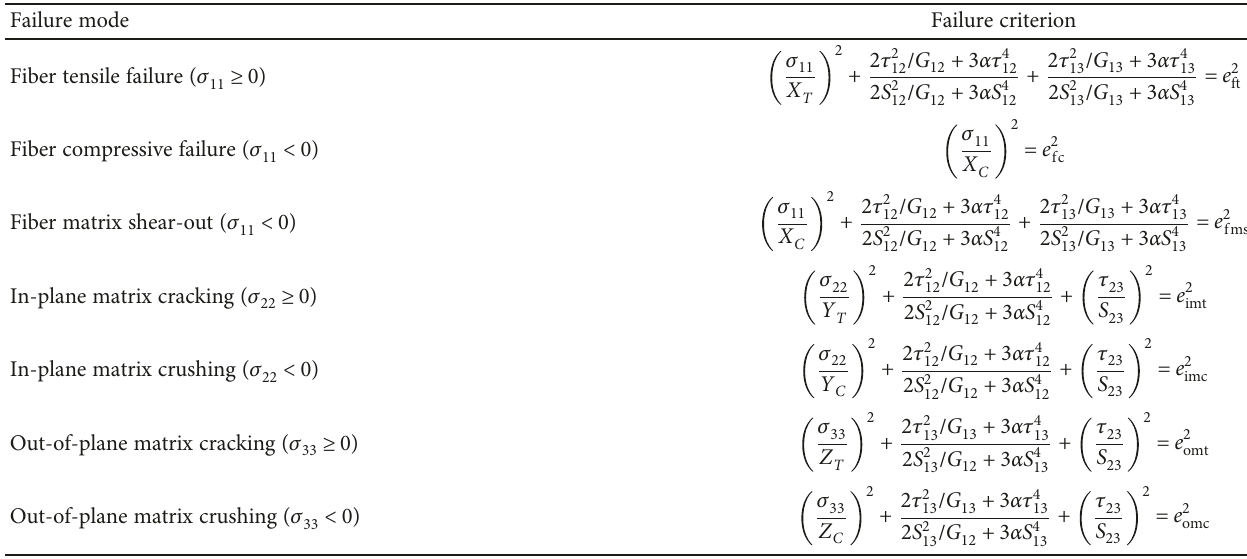
Table 3: Failure criteria for unidirectional lamina [22].